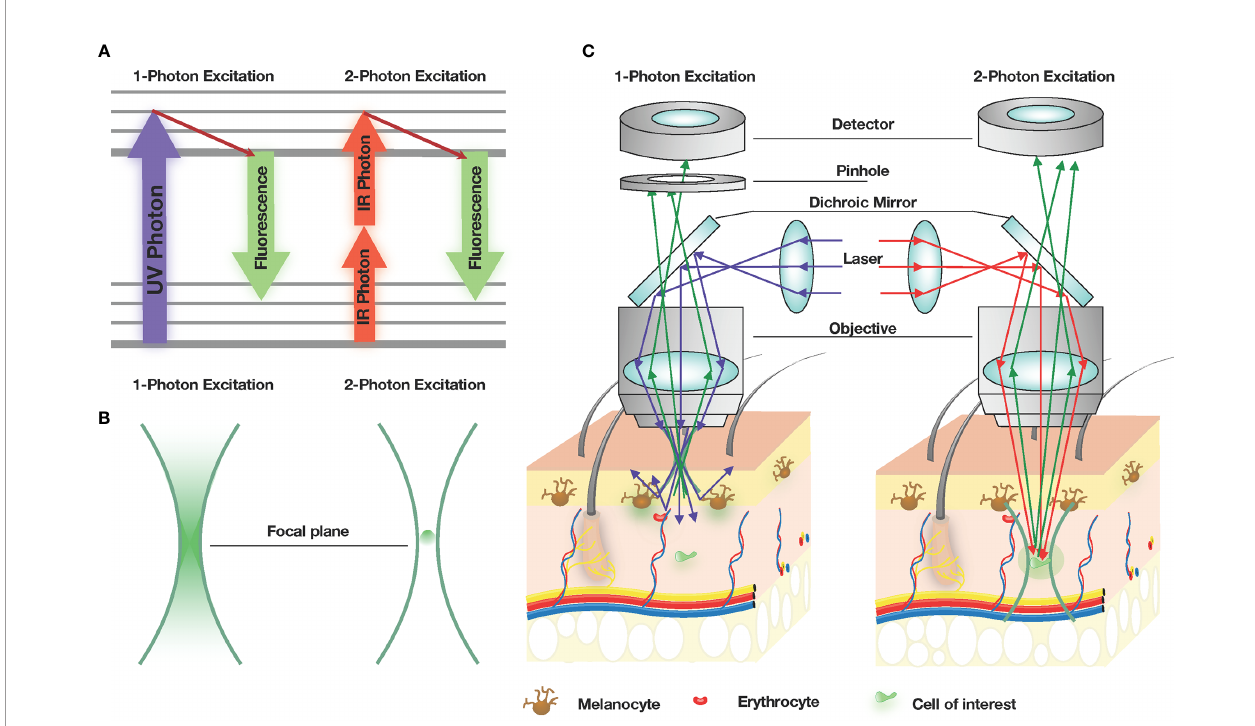
FIGURE 1 | 2P-microscopy is the gold standard for intravital imaging. (A) Jablonski diagram, illustrating the principles of excitation with one Ultraviolet (UV) photon and two Infrared (IR) photons. (B) Spatial con fi nement of signal generation. 1-photon excitation generates visible (green) signal in the entire cone of fl uorescence, while 2-photon excitation generates a signal only at the focal spot. (C) 1-photon excitation microscopy of the skin leads to a low light penetration, which becomes scattered by melanocytes and erythrocytes, while 2-photon excitation leads to a deeper penetration will less light